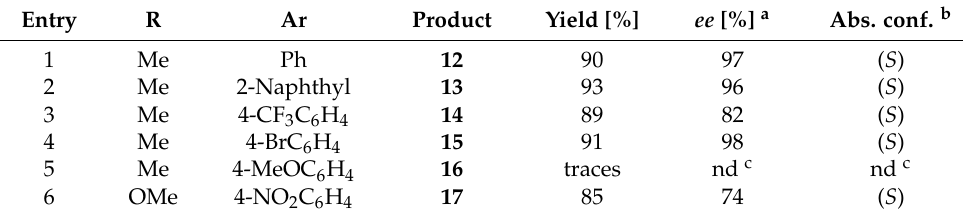
Table 4. Asymmetric MBH reaction promoted by aziridine-phosphine 6